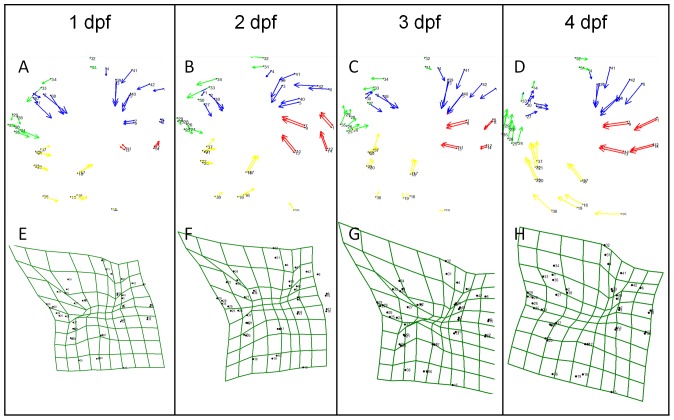
Vector analyzes, and thin plates spline morphometrics of lateral view surgery adults.(A)–(D) vector analyzes comparing the control side of the head to the surgery side. Vectors are grouped based on their similar response to surgery. Group one consists of landmarks 1–10 and 39–42 (blue), group two has landmarks 11–14 (red), group three has landmarks 15–23 and 36–37 (yellow) and group four has landmarks 24–30 and 33–36 (green). (E–H) are thin plate splines of surgery conducted at 1 to 4 dpf.